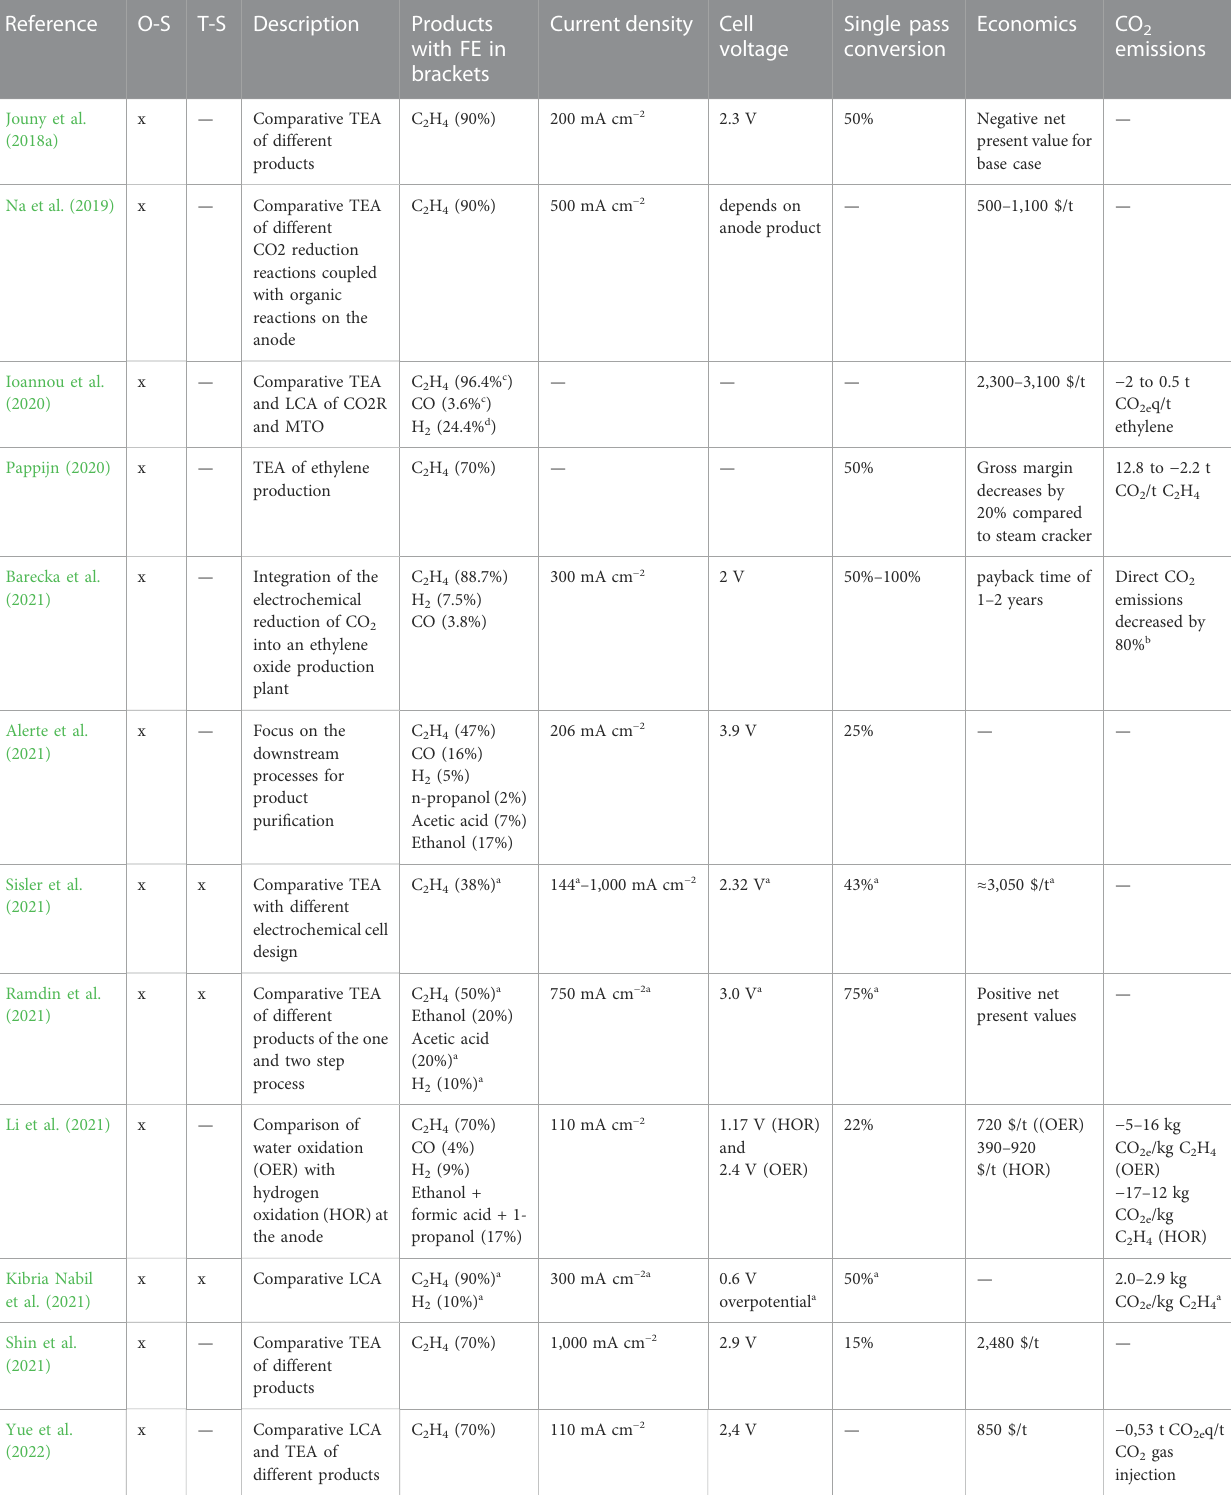
TABLE 2 Overview of process designs and assessments of two-step and one-step electrochemical reduction of CO 2 (O-S: one-step process, T-S: two-step process).